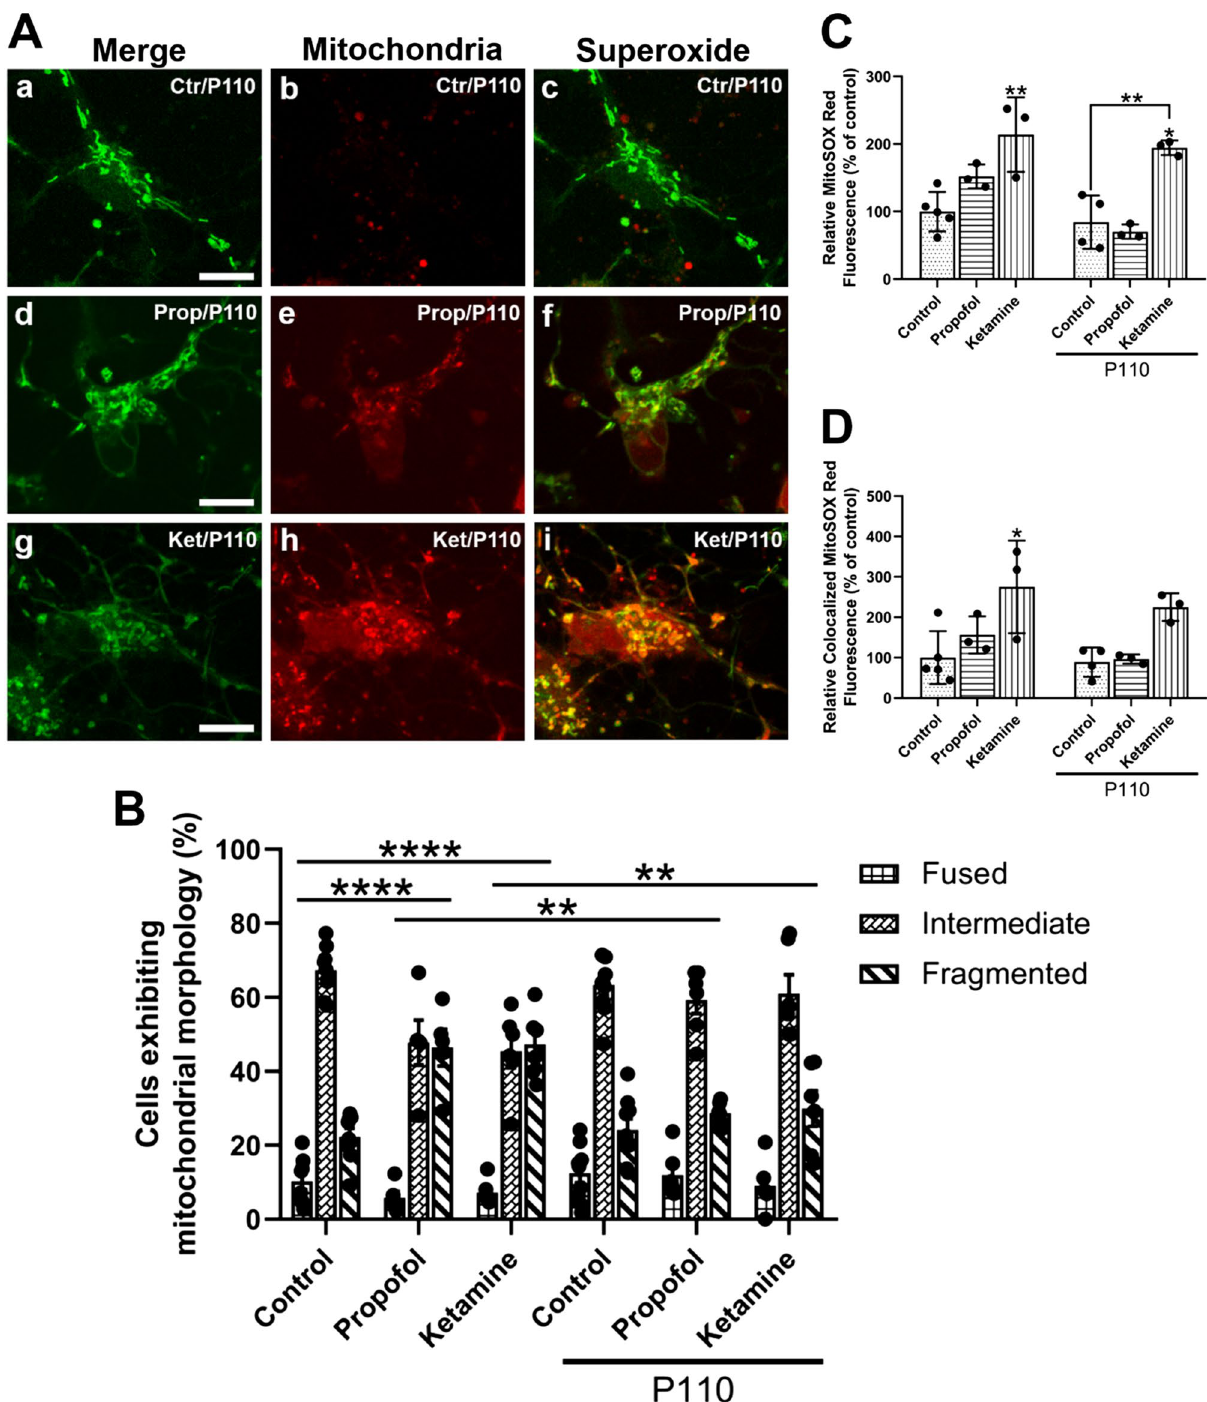
Figure 7. P110 reverses propofol-induced SO production and mitochondrial fragmentation. Representative cropped fluorescent images showing neurons from each condition which are co-stained with MitoTracker Green FM for mitochondria and the SO indicator MitoSOX Red (A) . Quantification of predominant mitochondrial morphology in each treatment (B) . For the ease of comparison, the control and anesthetic alone data are recapitulated here. P110 alone did not affect mitochondrial morphology whereas P110 pre-treatment fully rescued against propofol and ketamine-induced fragmentation. Quantification of relative SO production. For the ease of comparison, the control and anesthetic alone data are recapitulated here (C) . P110 alone did not affect SO production, however, P110 pre-treatment completely protected against propofol-induced SO production but not ketamine-induced SO production. Quantification of relative SO based on MitoSOX Red signal which colocalized to MitoTracker Green FM (D) . For the ease of comparison, the control and anesthetic alone data are recapitulated here. P110 reversed propofol-induced elevation in mitochondrial SO production but not ketamine-induced changes. Two-Way ANOVA. * p < 0.05, ** p < 0.01, **** p < 0.0001 as determined by pairwise comparison of post-hoc tests. Bars indicate ± SD across at least biological replicates. Each data-point indicates the either the percentage of cells that exhibited a specific morphology per dish, or the mean SO signal recorded per dish. Scale bars indicate 10